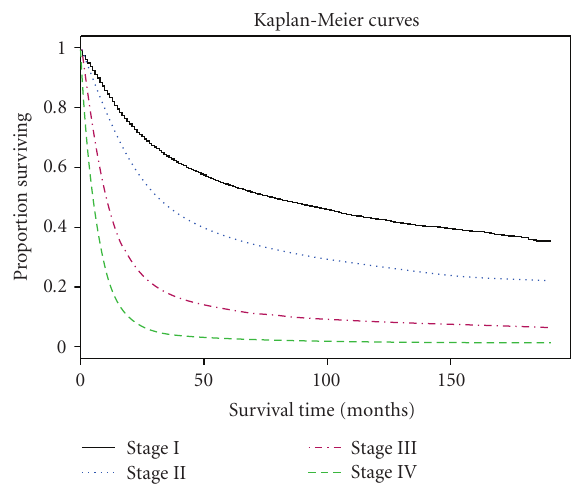
Figure 3: Survival curves of four TNM stages.